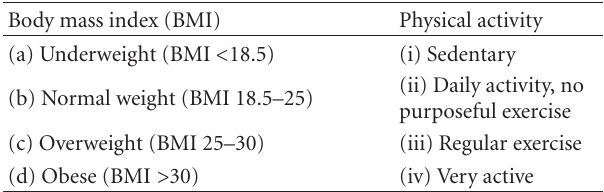
Table 1: Metabolic classification based on body mass index and physical activity